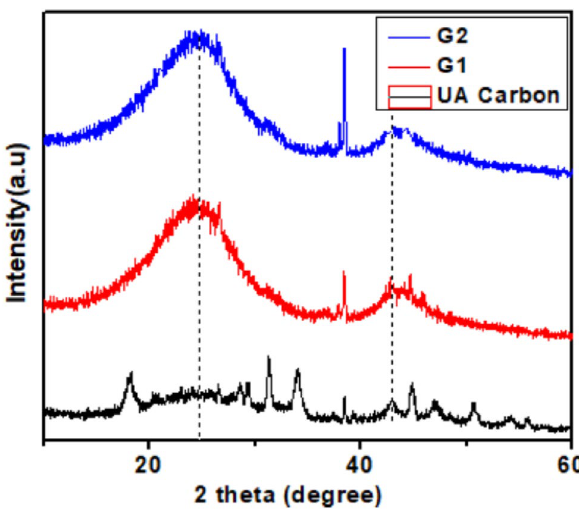
Fig. 3 XRD patterns micrographs of ( a ) UA carbon, ( b ) G1, (c) G2